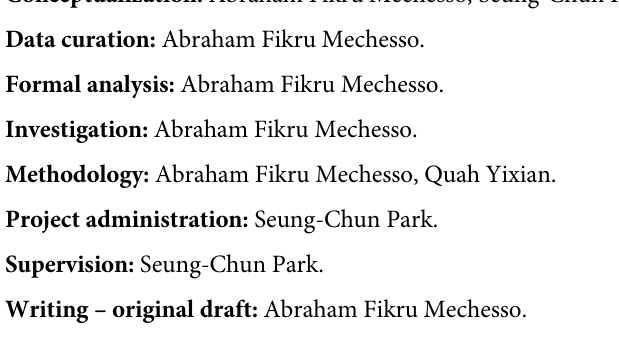
Typhimurium LVPP-STI15 biofilm. Values represent mean ± SEM of four independent exper- iments. S2 Fig. Cytokine expression of IL-8 (A), IL-10 (B), IL-6 (C), IL-1 β (D) and TNF α (E) in Caco-2 monolayers co-cultured with methyl gallate (MG), tylosin (Ty) and various concen- trations of their combination (MT) during 8 h infection with S . Typhimurium. Cell: non- infected and non-treated control. Salmonella : infected, but non-treated cells. Results mean ± SEM of three independent experiments. MG = 32 μ g/mL; Ty = 64 μ g/mL; 1 / 16 × MT = 8 μ g/mL MG and 16 μ g/mL Ty; 1 / MT = 16 μ g/mL MG and 32 μ g/mL Ty; and ¼× 8 × MT = 32 μ g/mL MG and 64 μ g/mL Ty. � P < 0.05 compared to infected, but non-treated cells; τ P < 0.05 compared to Ty; π P < 0.05 compared to MG; and # P < 0.05 compared to both MG and